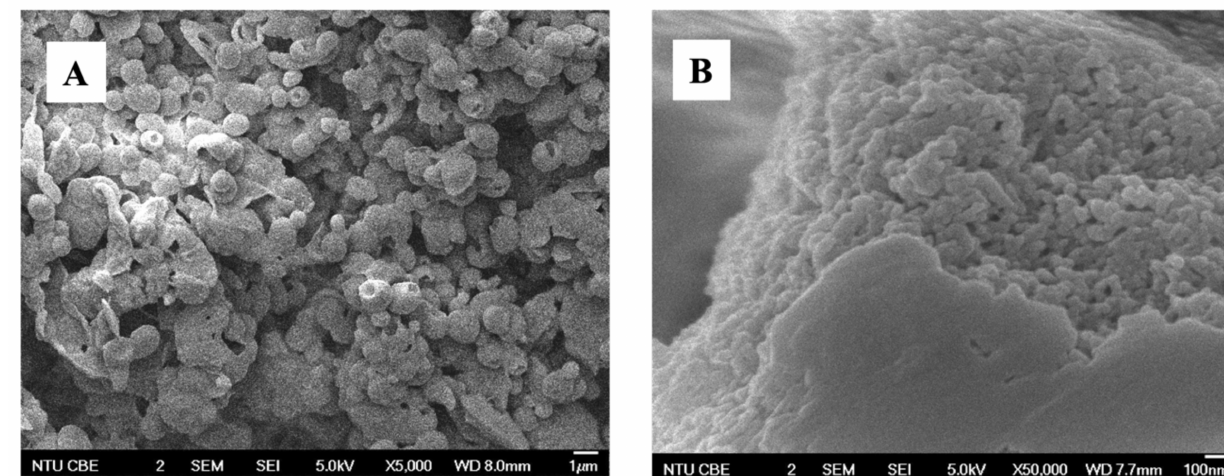
Figure 1. FESEM images of the lyophilized CUR-BSA nanoplex viewed at ( A ) low and ( B ) high magnifications.